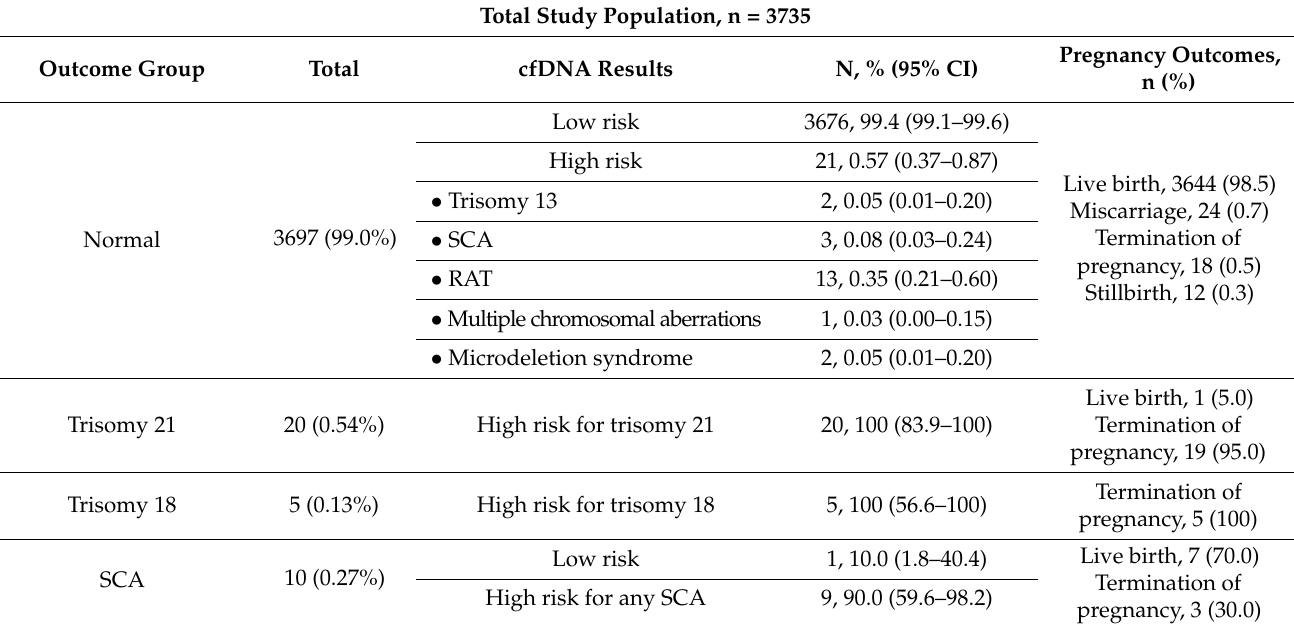
Figure 1. Overview of cfDNA and outcomes during the two reporting periods. A total of 21 cases had false-positive results, which had normal pregnancy outcomes. Table 3. Screening performance of cfDNA results and pregnancy